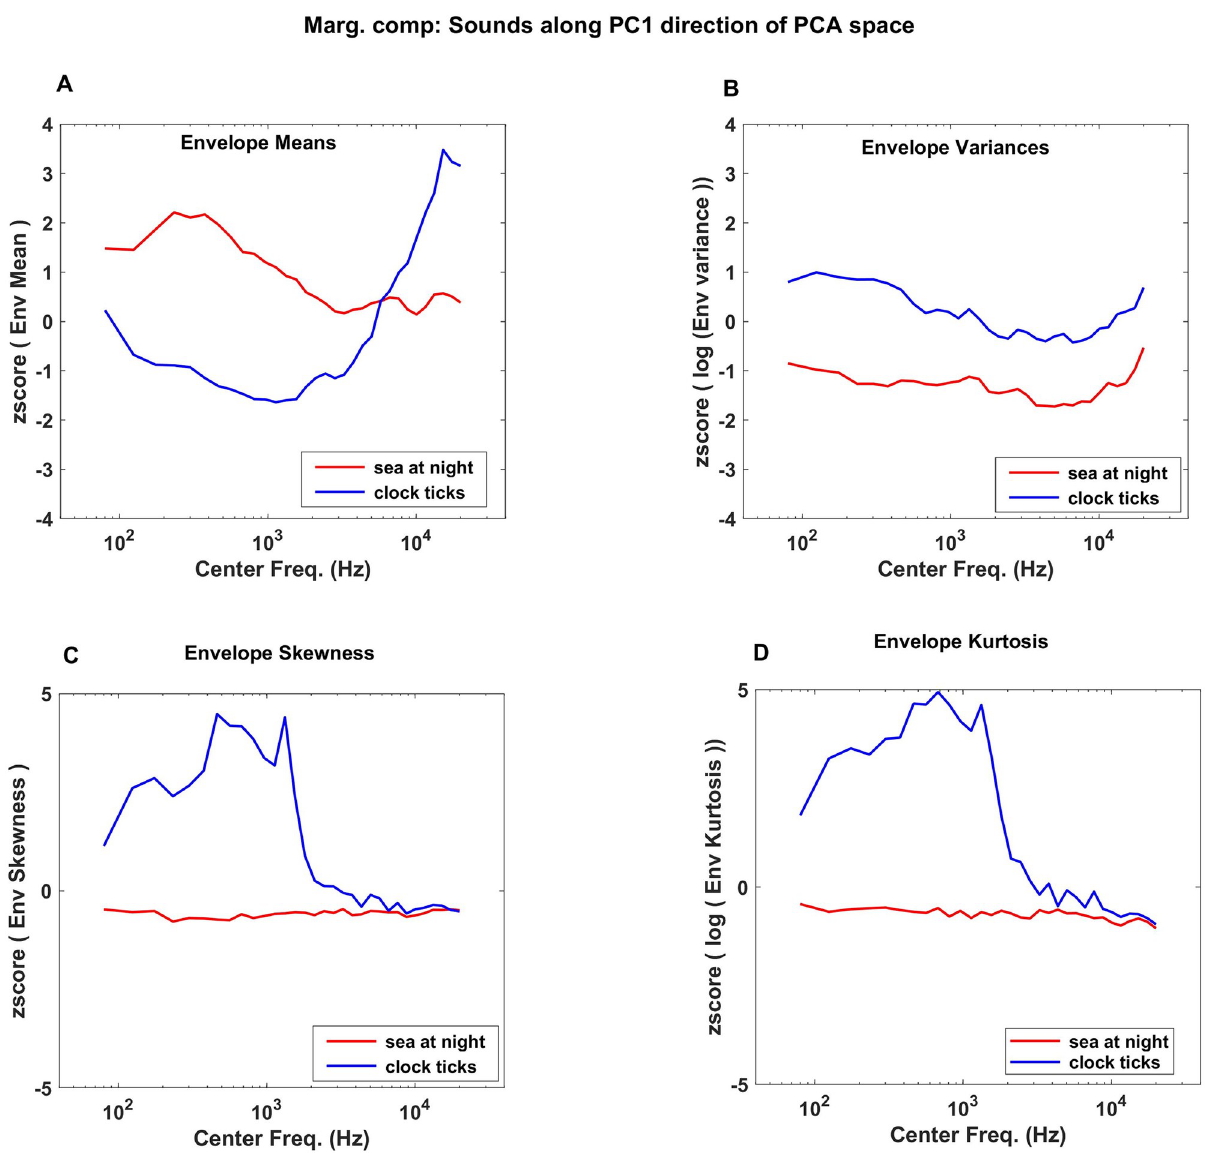
Fig 4. Comparison between the envelope statistics of “sea at night” from one end of PC1 dimension and “clock ticks” from the other end. (A) “Sea at night” has higher envelope mean than “clock ticks” as it is in the lower end of PC1 dimension (B, C, D) Envelope of “clock ticks” with high variance, skewness and kurtosis than “sea at night” for frequencies above